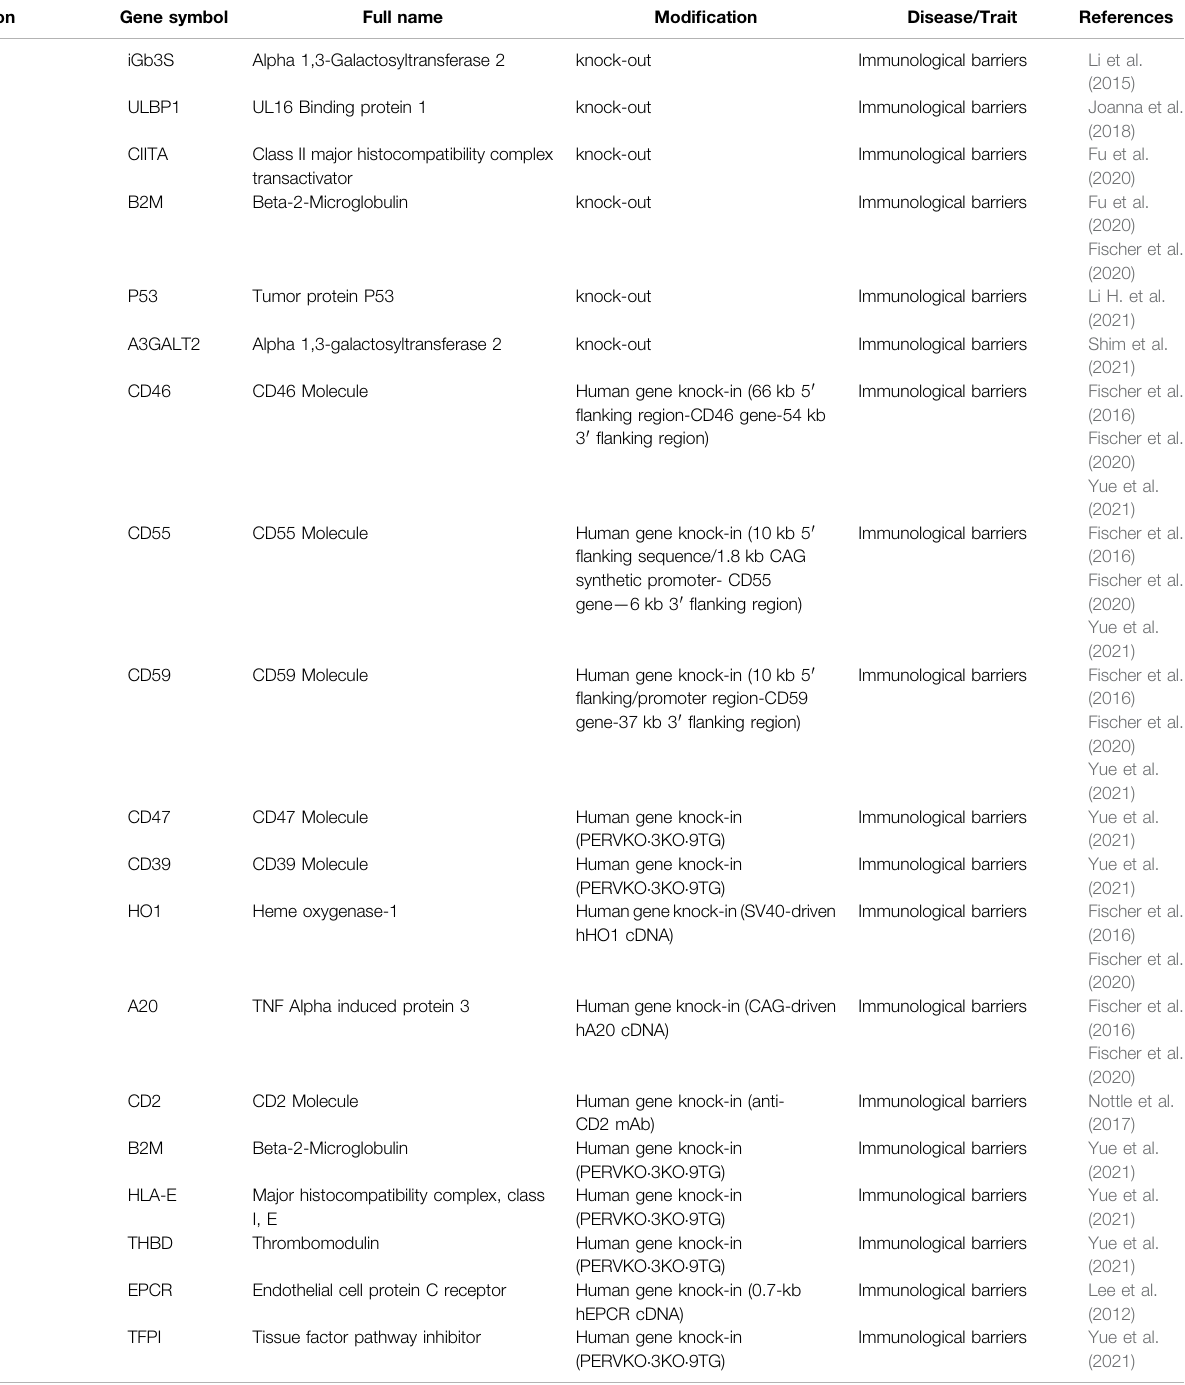
TABLE 1 | ( Continued ) Summary of genetic changes introduced into porcine genome by CRISPR